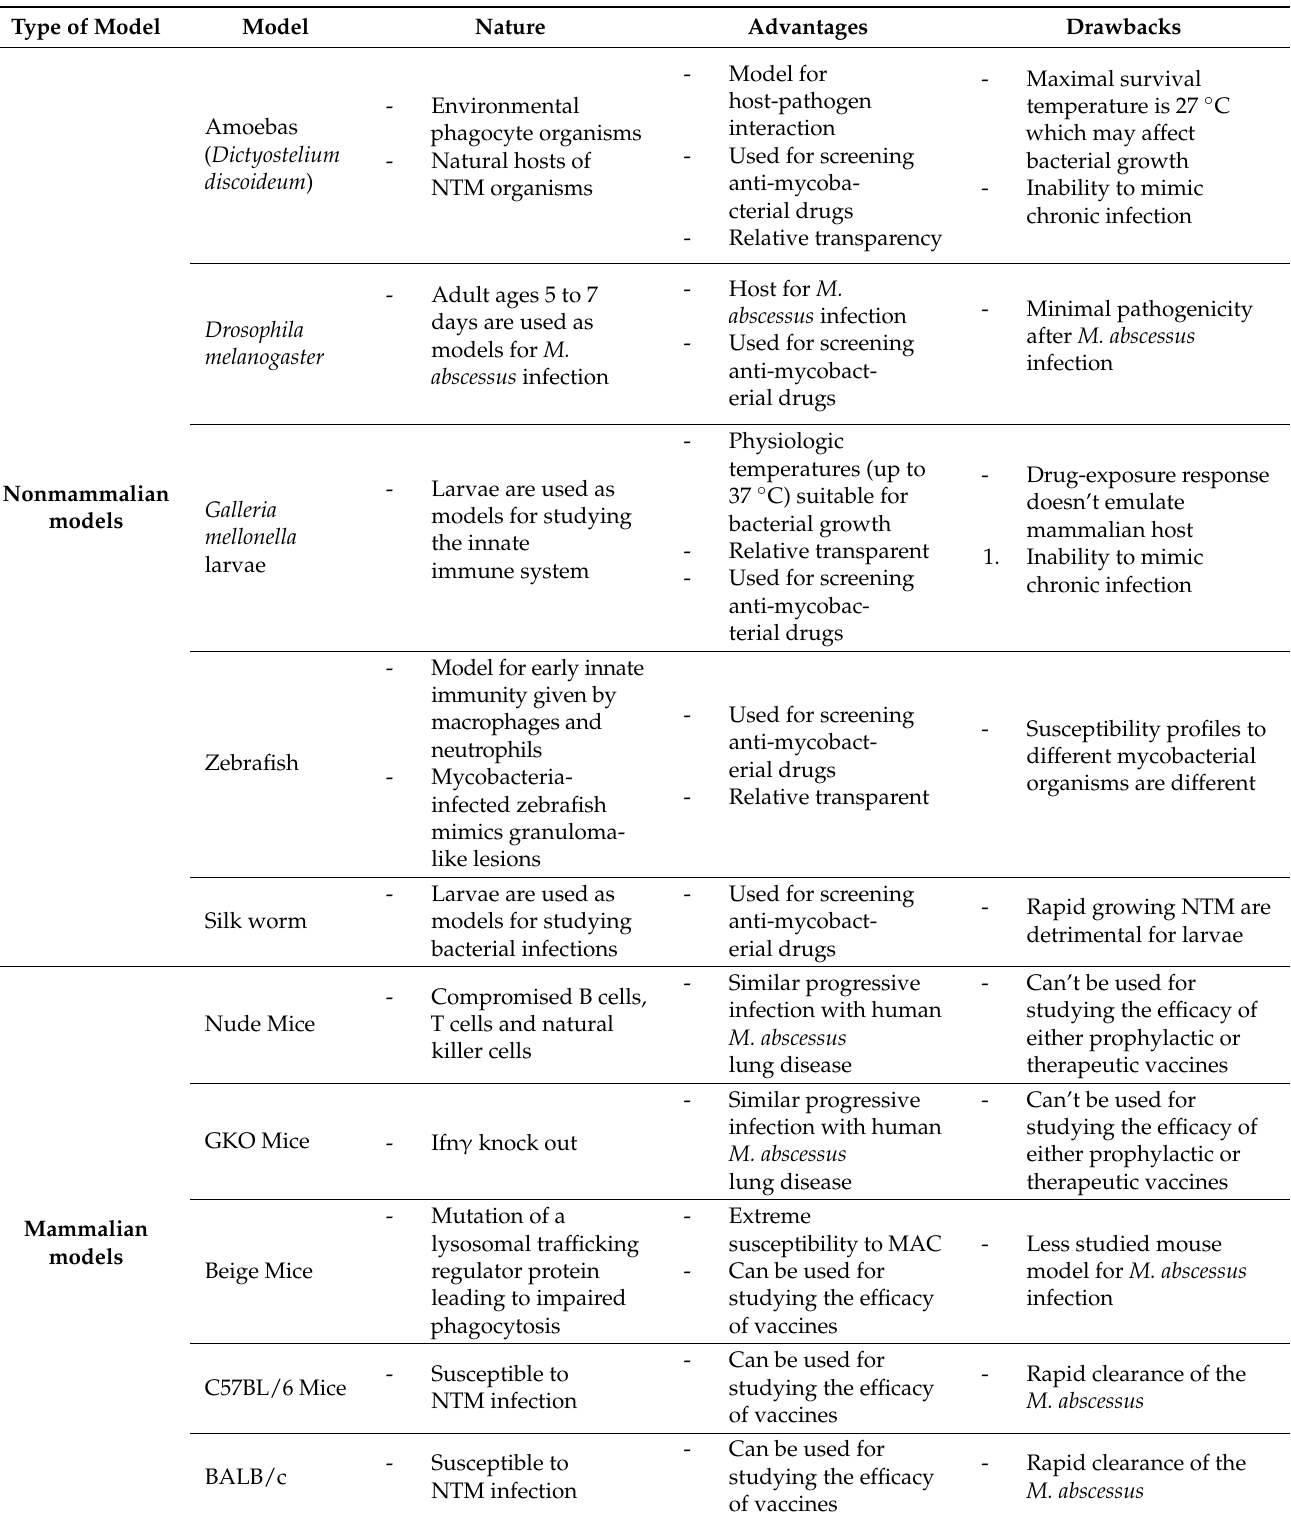
Table 2. Summary of different models used for M. abscessus